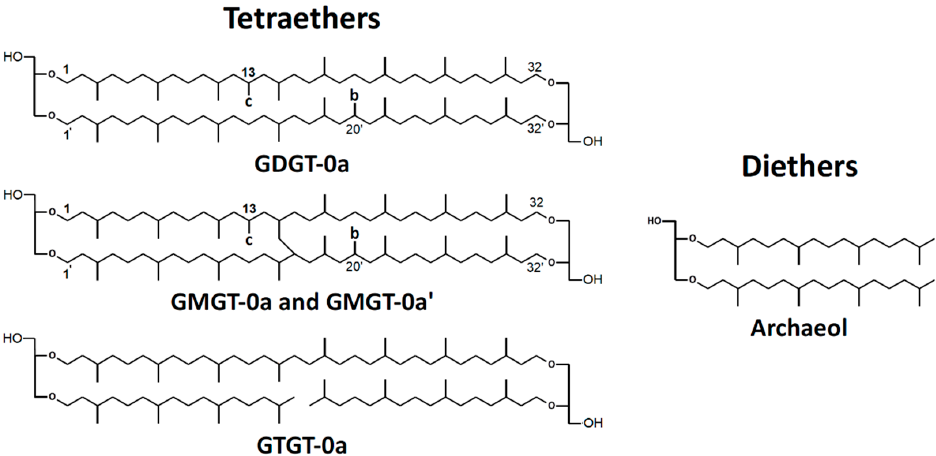
Figure 1. Structures of polar headgroups and core lipids found in M. marburgensis . Abbreviations of core lipids are: GDGT (glycerol dialkyl glycerol tetraether), GMGT (glycerol monoalkyl glycerol tetraether), and GTGT (glycerol trialkyl glycerol tetraether). “0”: zero rings in the alkyl chains; “a”, “b”, and “c”: no, one, or two additional methyl groups, as indicated in the structures [14]. Note that the exact positions of the additional methyl groups and the covalent carbon–carbon bonds between the isoprenoid chains of GMGT-0 are unknown.